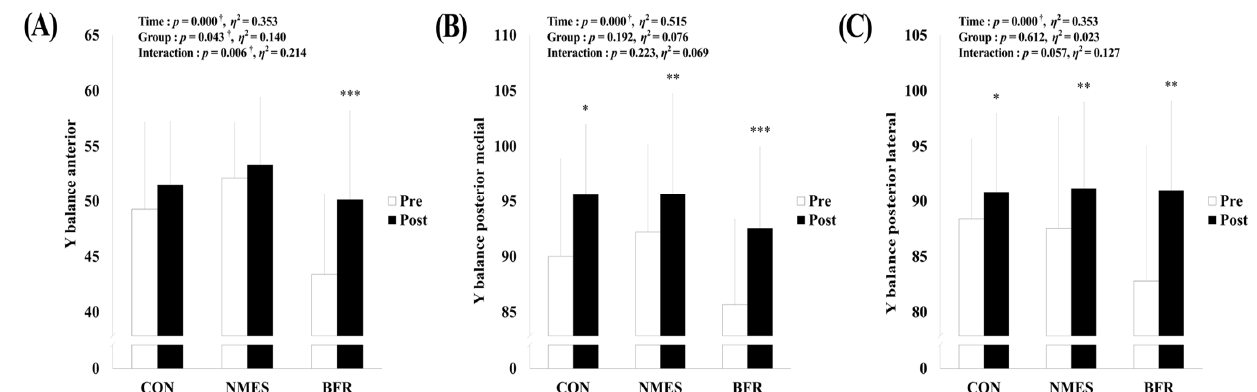
Figure 6. Changes in balance via rehabilitation intervention in each group. ( A ) Change in Y-balance anterior. ( B ) Change in Y-balance posterior medial. ( C ) Change in Y-balance posterior lateral. CON, control group; NMES, neuromuscular electrical stimulation group; BFR, blood flow restriction group. Signi fi cant interaction or main e ff ect: † p < 0.05; Significant difference in each group via re ‐ habilitation intervention: * p < 0.05, ** p < 0.01, *** p < 0.001.